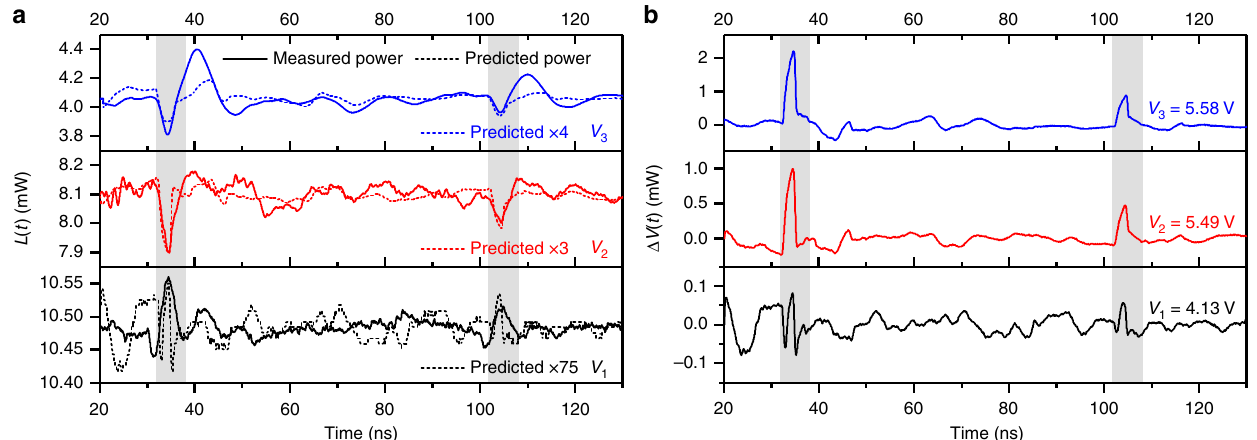
Fig. 3 Measurement and prediction of effect of the acoustic modulation. Temporal responses of the QCL to the fi rst two strain pulses at three different QCL operating biases V b = V 1 to V 3 : a THz power modulation, L ( t ) (solid lines) and b QCL voltage perturbation, Δ V ( t ). Predicted power modulation waveforms are shown in ( a ) (dashed lines), with amplitudes normalised to the experimental data by factors of 75, 3 and 4 for V 1 , V 2 and V 3 , respectively. Highlighted regions indicate the temporal position of the acoustic modulations. Incident strain pulses were generated with an optical pulse energy of 10 µ J. Data have been smoothed using a 20-point rolling average fi lter. Source data are provided as a Source Data fi